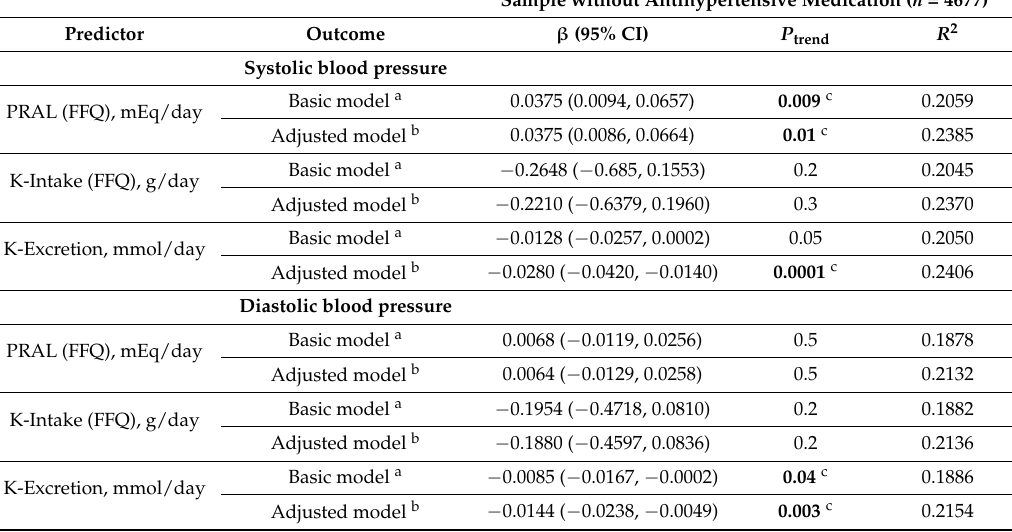
Table 3. Linear regression analyses on the association of PRAL and potassium in sex-balanced quintiles as continuous predictor variables with blood pressure levels as continuous outcome variables in a reduced DEGS1 study sample of participants without antihypertensive medication ( n = 4677). Sample without Antihypertensive Medication ( n =